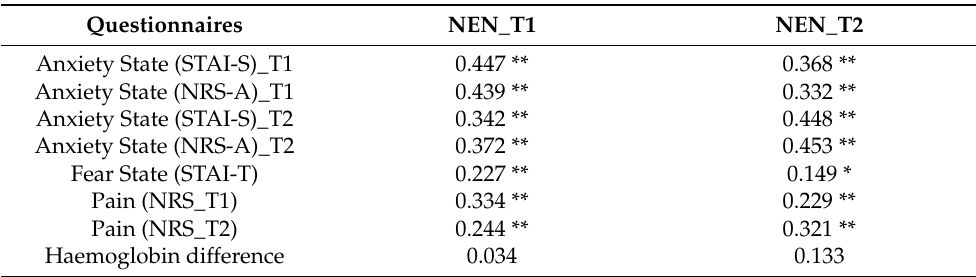
Table 2. Relationship between the need to entrust the newborn under the care of staff and anxiety, pain ( n = 200), and haemoglobin difference ( n = 198).